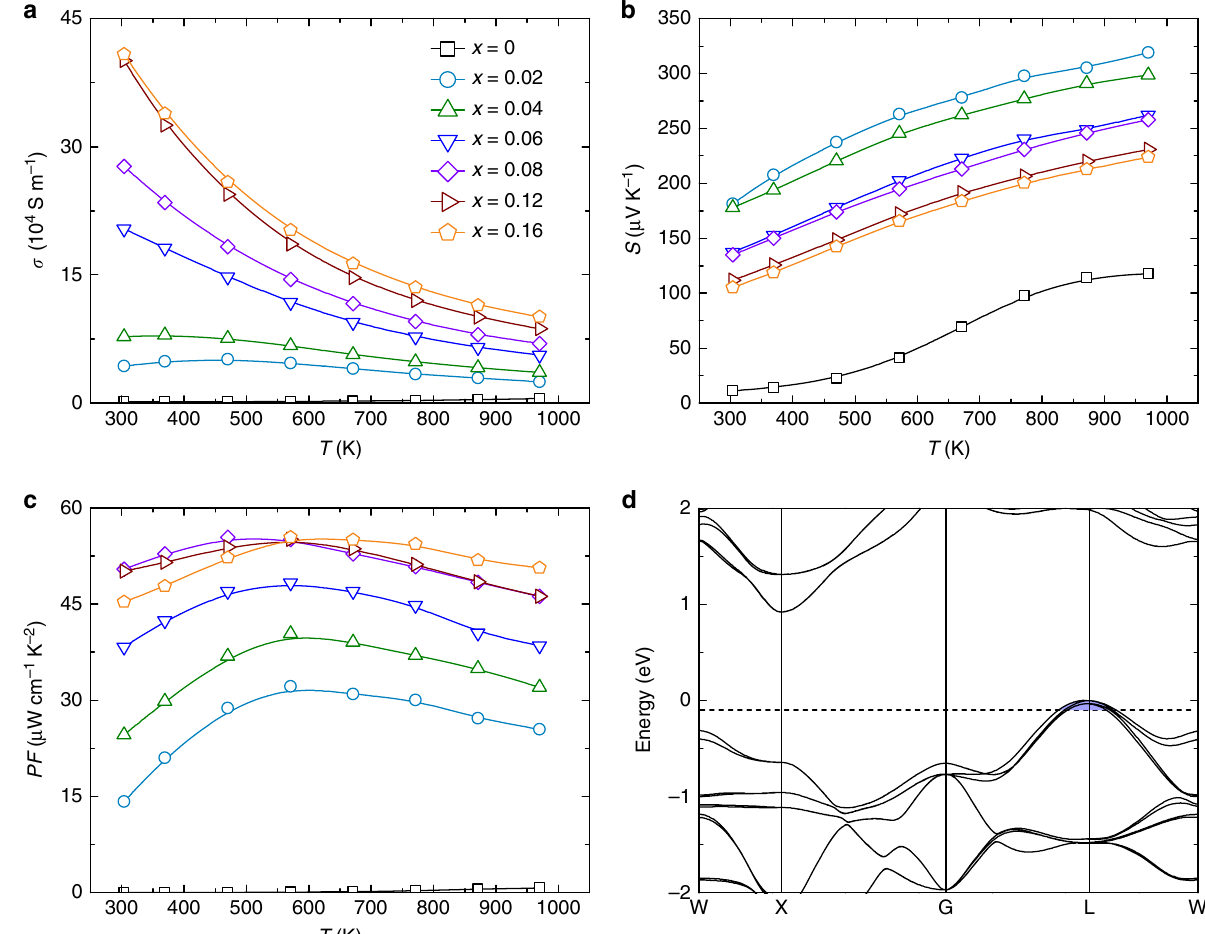
Fig. 3 Electronic properties of TaFeSb-based half-Heuslers. Temperature-dependent a electrical conductivity, b Seebeck coef fi cient, and c power factor of Ta 1- x Ti x FeSb ( x = 0, 0.02, 0.04, 0.06, 0.08, 0.12, and 0.16). d Band structure of